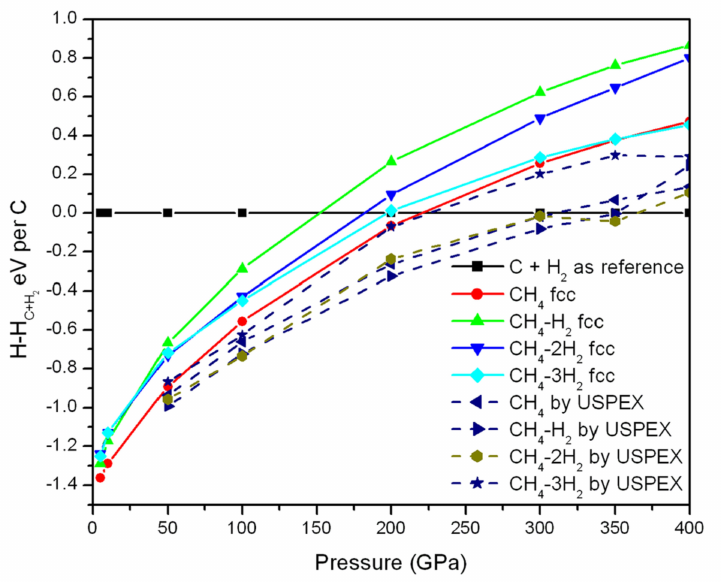
Figure 6. Computed enthalpy (with respect to carbon and H 2 ) as a function of pressure.